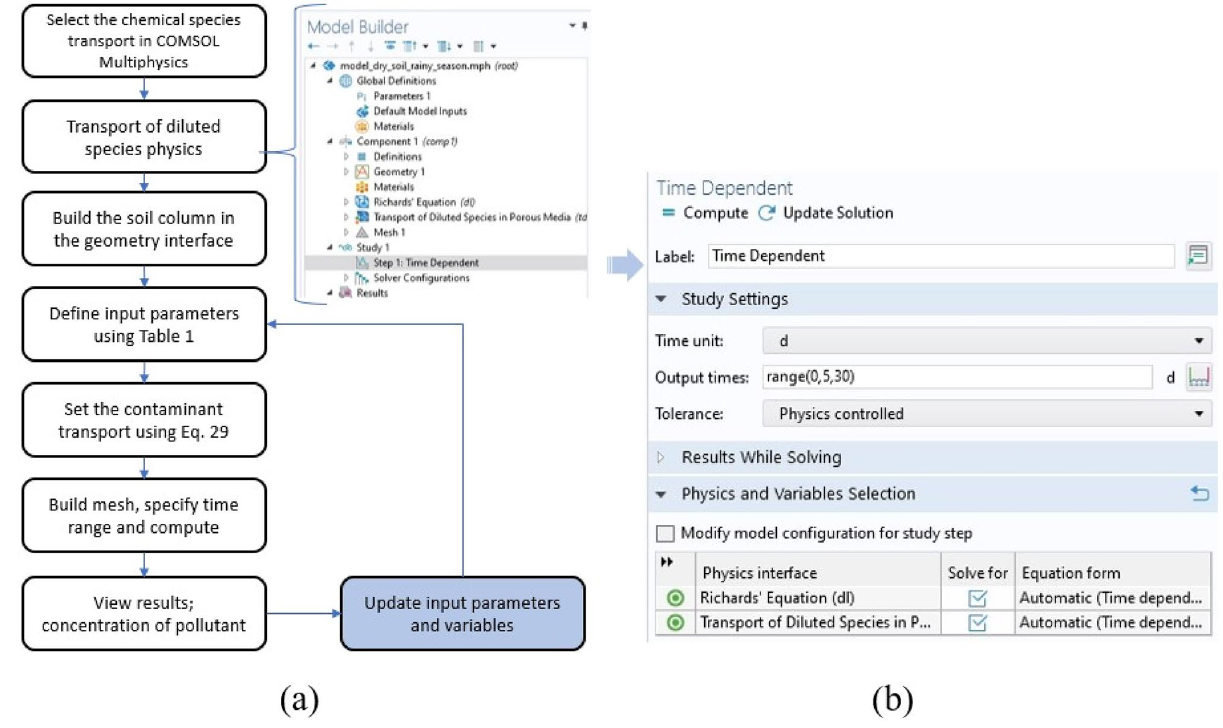
Figure 3. ( a ) Procedure used to implement the numerical model in COMSOL ( b ) screen shots of software